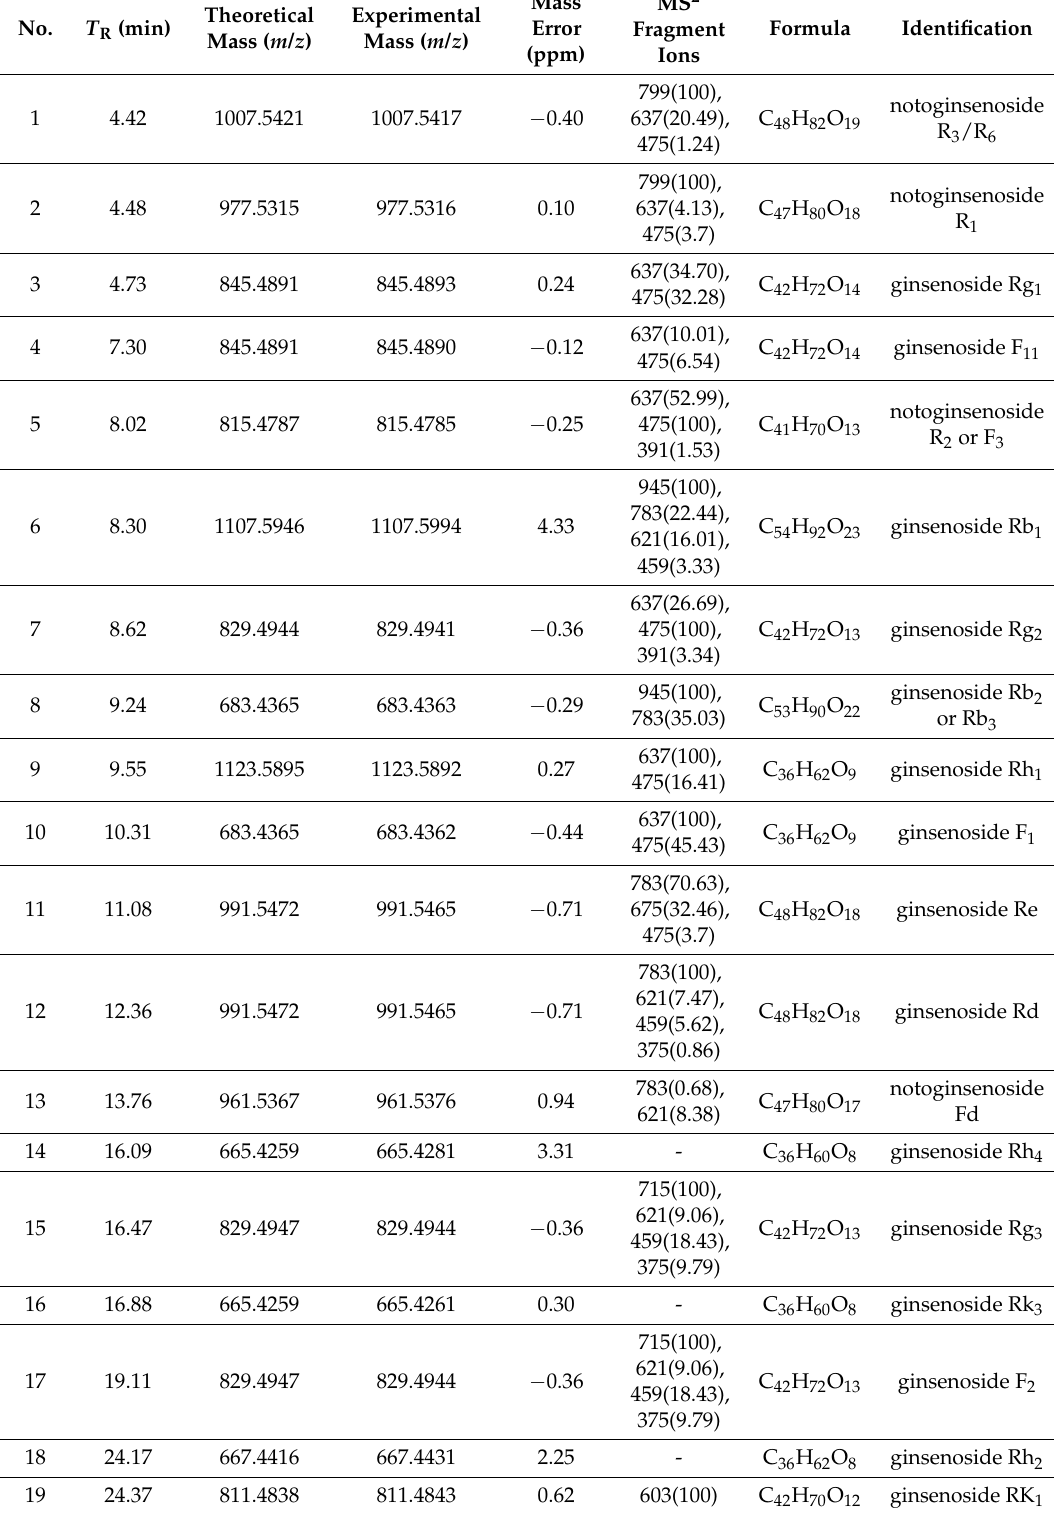
Table 1. All the identified or tentatively identified components of PNS and their UPLC-MS/MS data.